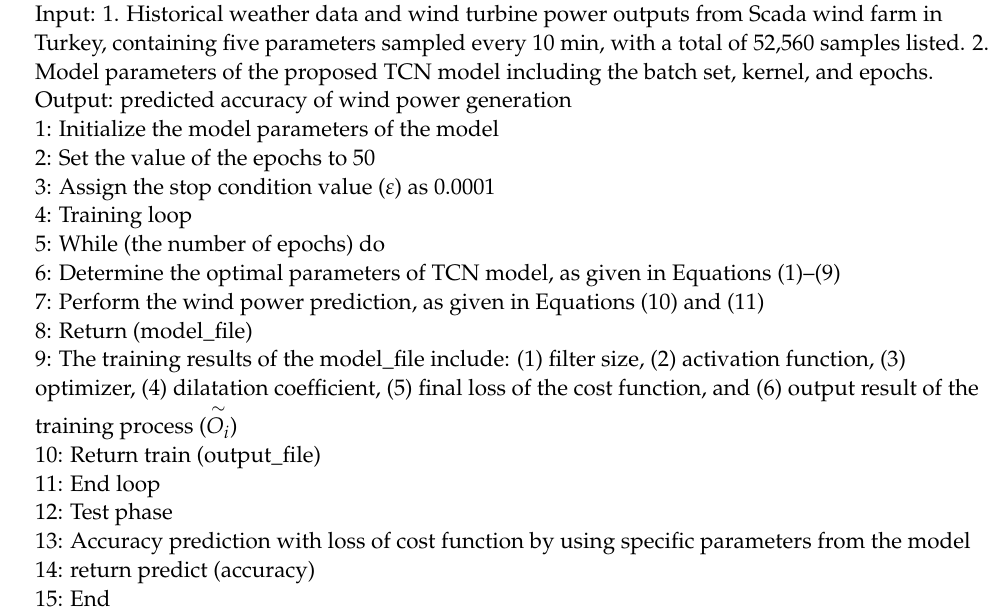
Algorithm 1 Pseudocode of the TCN-based model for wind power prediction.